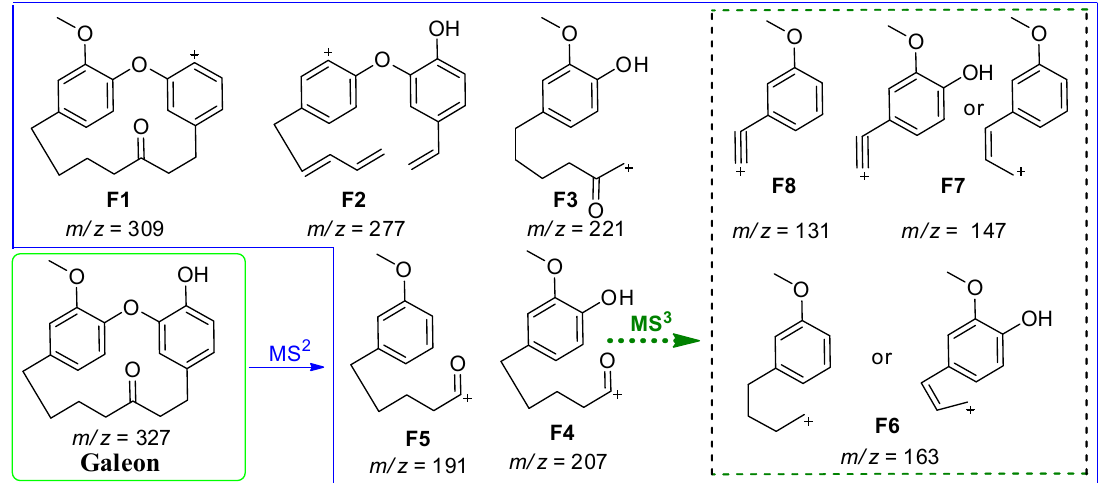
(F3), 207 (F4), 191 (F5), 163 (F6), 147 (F7), and 131 (F8), and the MS 3 fragmentation of the major